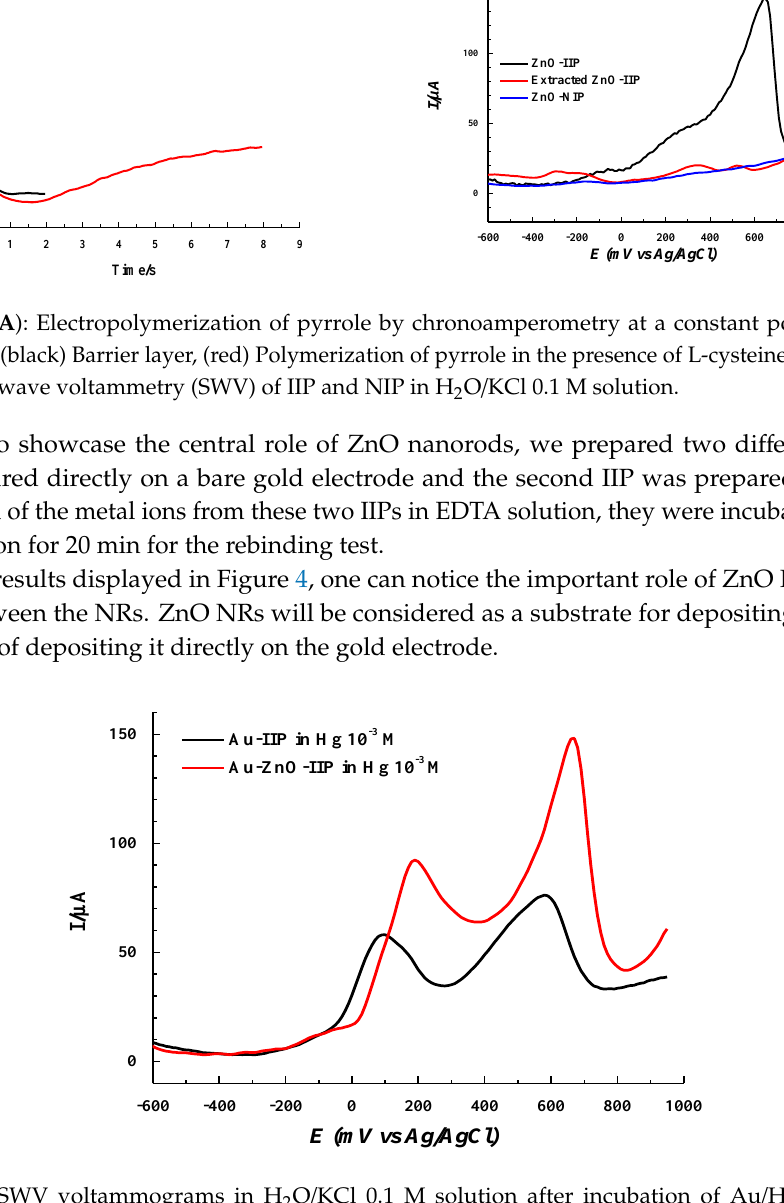
Figure 4. SWV voltammograms in H 2 O / KCl 0.1 M solution after incubation of Au / Hg-IIP and Au-ZnO / Hg-IIP in 10 − 3 M Hg 2 + . Conditions: E-pulse: 0.01 V, E-step: 0.01 V, frequency: 25 Hz, equilibration time: 2 s.